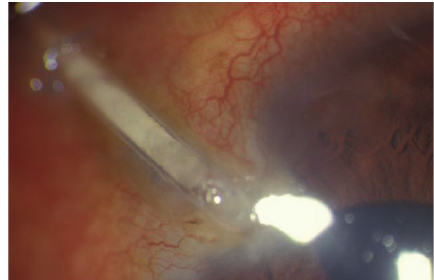
Figure 3: Eye of patient with extruded tube.